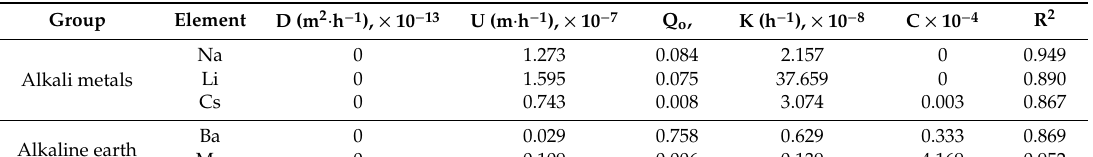
Table 14. Nonlinear curve fitting parameters of the cumulative leach fraction of alkali and alkaline earth metals: ABS-Waste (25).